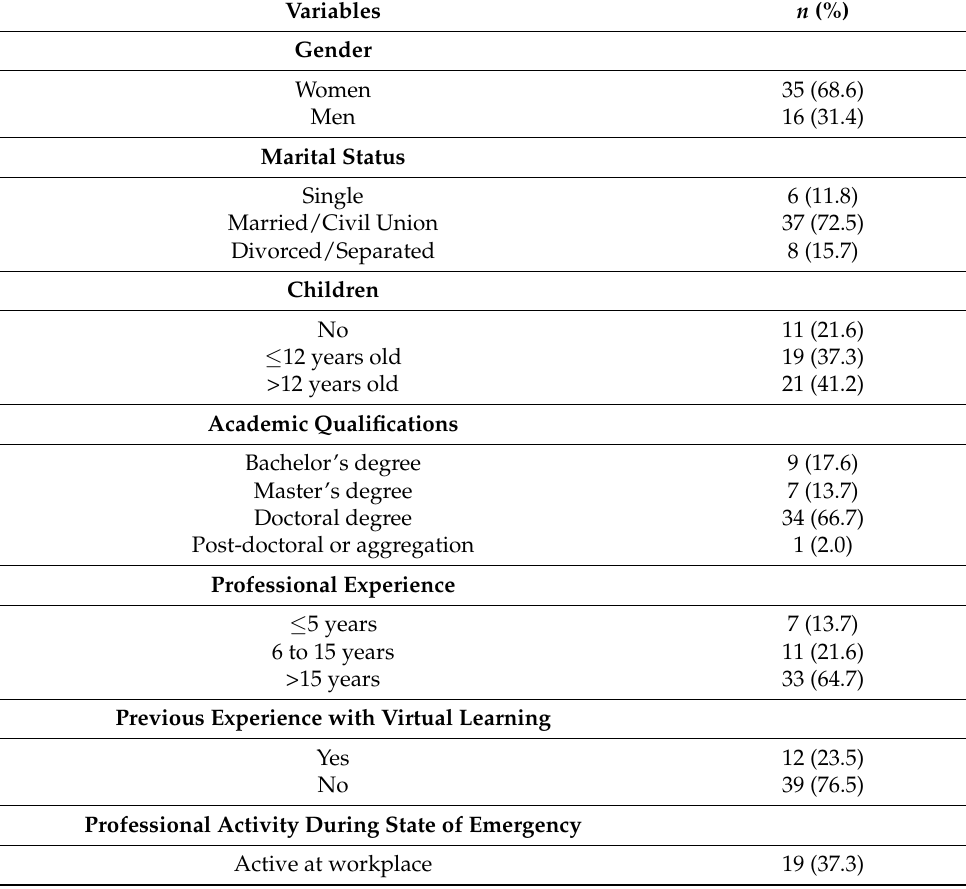
Table 1. Distribution of sociodemographic